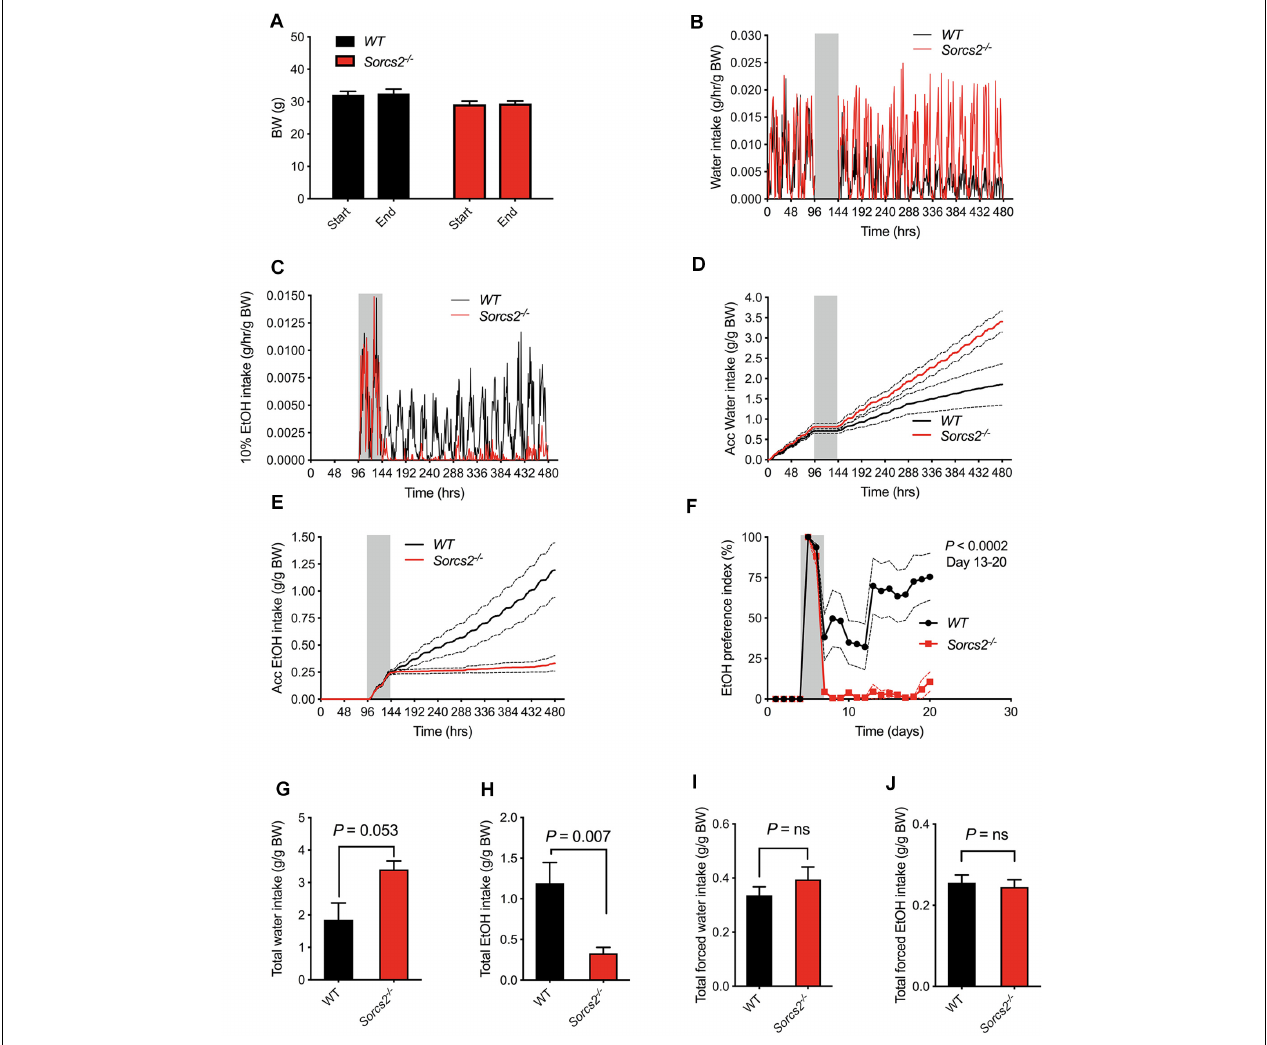
FIGURE 3 | Sorcs2 − / − mice show decreased voluntary alcohol consumption. (A) Bodyweight before and after experiment, showing no significant difference in bodyweight between WT and Sorcs2 − / − mice ( P > 0.9). (B,D,G) Intake of water during the experiment, showing there is a close to significant difference in intake of water between WT and Sorcs2 − / − mice, where Sorcs2 − / − mice had the highest intake ( P = 0.0530). (C,E,H) Intake of 10% ethanol during the experiment showing that WT mice drank significantly more alcohol compared to WT mice ( P = 0.007). (F) Preference index of ethanol over the course of the experiment, showing that WT had a significant higher preference for alcohol compared to Sorcs2 − / − mice ( P < 0.0002 for day 13–20). The gray bars (in panel B–F ) indicate period with forced ethanol intake (no water available). There was no significant difference in intake of water when it was the only drinking option ( P = 0. 46, panel I ) or in forced ethanol intake ( P = 0.81, panel J ) ( n = 8 mice per genotype). In panel (B,C) , mean without SEM are shown for sake of simplicity. Red lines are intake for Sorcs2 − / − mice and black likes are intake for